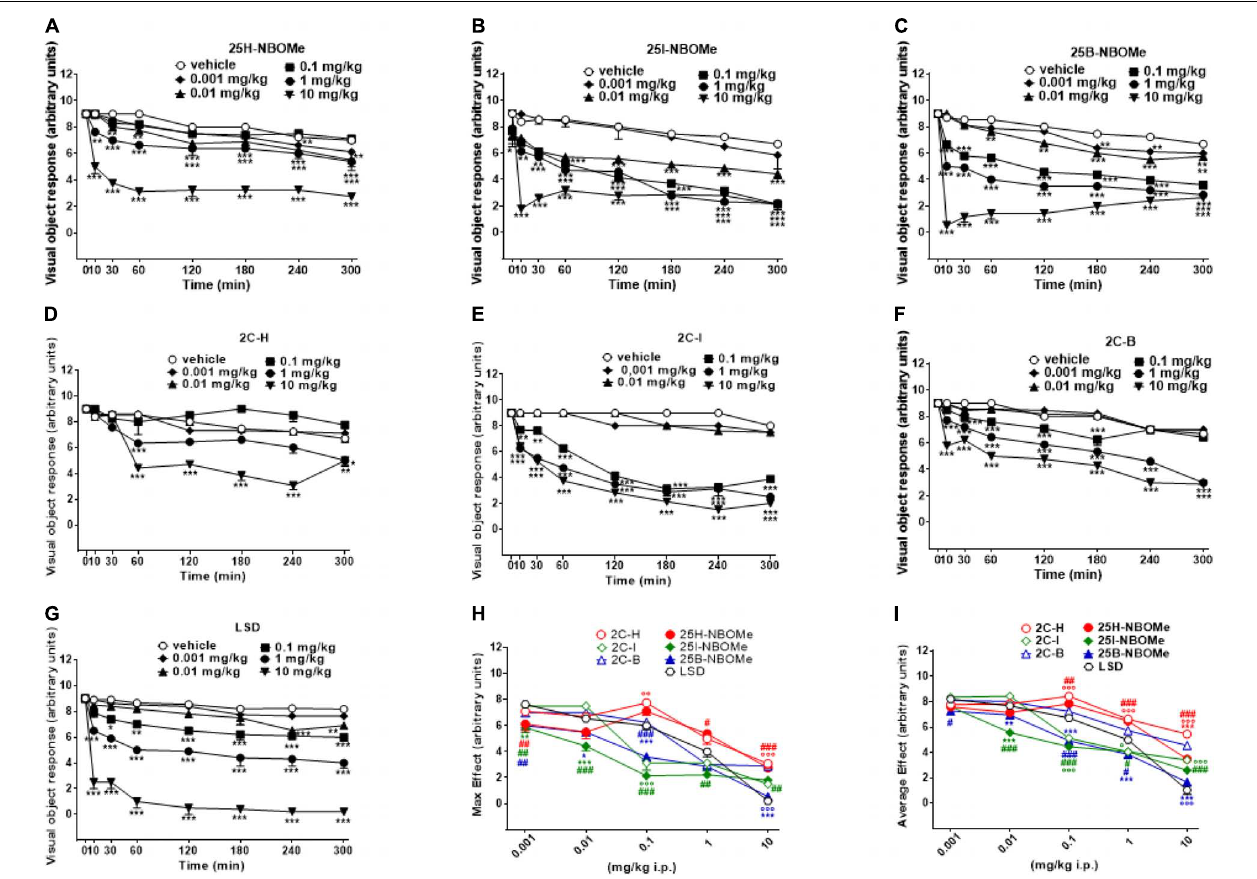
FIGURE 2 | Effect of 25H-NBOMe (0.001–10 mg/kg i.p.) (A) 25I-NBOMe (0.001–10 mg/kg i.p.) (B) 25B-NBOMe (0.001–10 mg/kg i.p.) (C) 2C-H (0.001–10 mg/kg i.p.) (D) 2C-I (0.001–10 mg/kg i.p.) (E) 2C-B (0.001–10 mg/kg i.p.) (F), and LSD (0.001–10 mg/kg i.p.) (G) on the visual object tests in mice, and comparison of the maximum (H) and average (I) effects observed in 5 h. Data are expressed as mean ± SEM ( n = 8/group). Statistical analysis was performed by two-way ANOVA followed by Bonferroni’s test (A–G) for multiple comparisons for the dose–response curve of each compound at different time points. The comparison of maximum effect observed in 5 h was also presented (H,I) . * p < 0.05, ** p < 0.01, *** p < 0.001 vs. vehicle; # p < 0.05, ## p < 0.01, ### p < 0.001 vs.